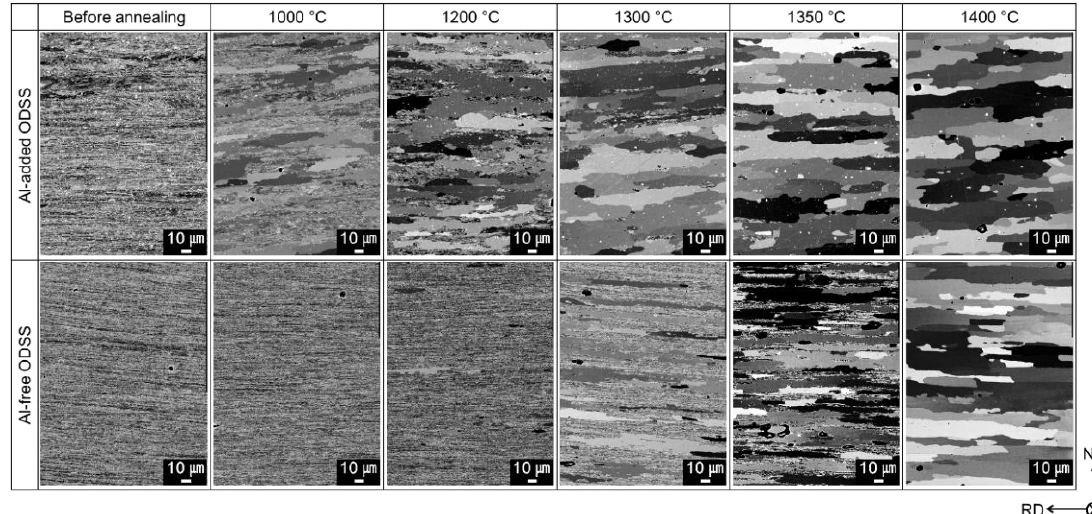
Figure 12. The change in grain morphology after dual processing in 15Cr-ODS ferritic steels with and without cold rolling.